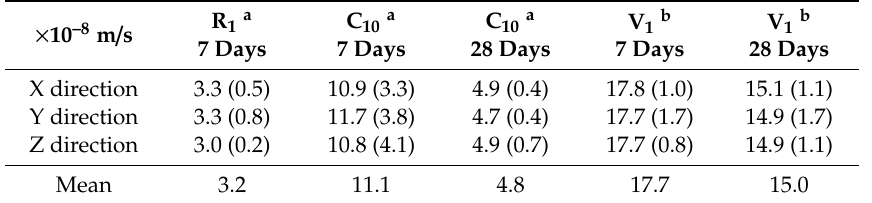
Table 5. Mean ( ± 1 s.d.) calculated hydraulic conductivity coe ffi cients from permeability simulations on 100 µ m x 100 µ m x 100 µ m cube